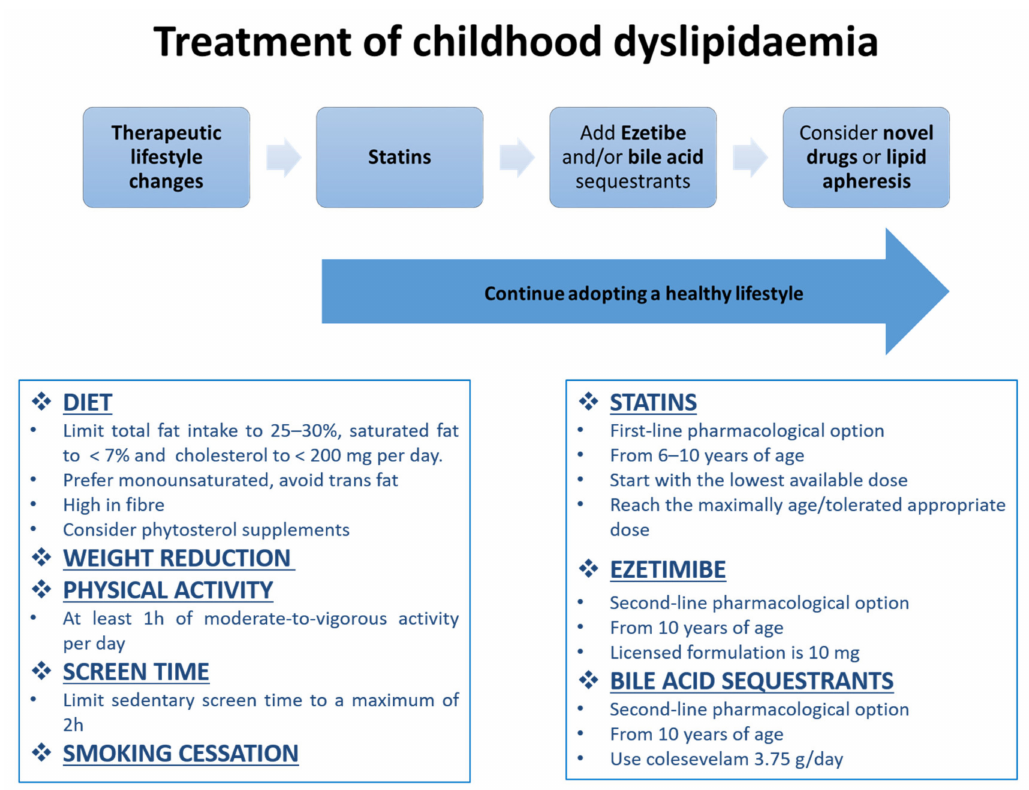
Figure 1. Treatment algorithm of childhood